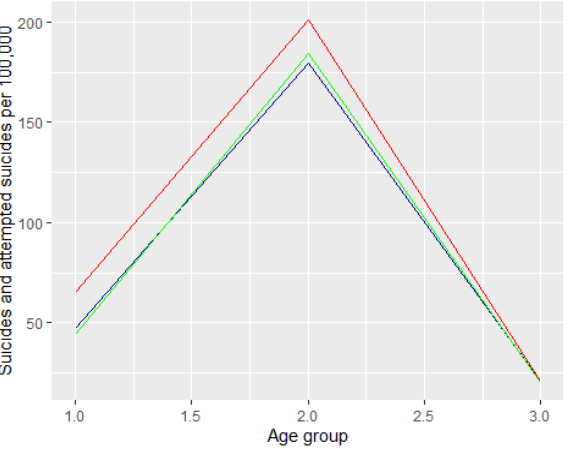
Figure 4. The number of suicide attempts per 100,000 in Poland between 2019 and 2021.